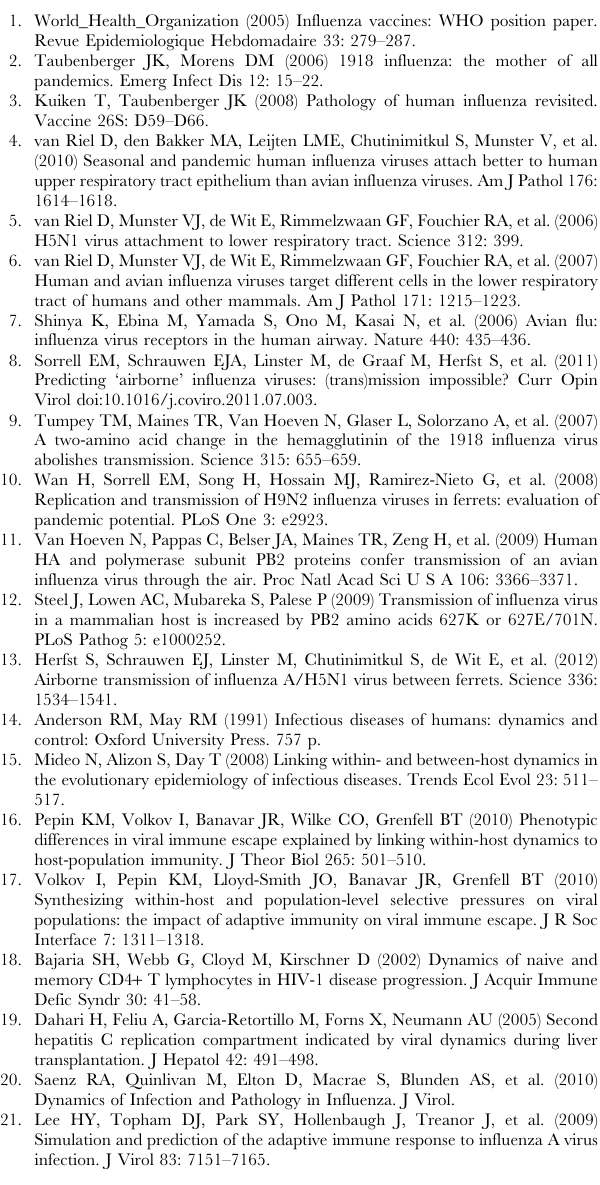
square. Infectivity rates are increasing from 1 to 5 as they differ per model. Standard errors are represented. Figure S3 Optimal patterns of tissue tropism based on more complex versions of the model. Contour plots of influenza virus reproductive number (color scales) in an immuno- logically naı¨ve population (R 0 ; left column ) and in a partially- immune population (R e ; right column ) are drawn when the infectivity rates b 2 (x axis) and b 1 (y axis) are varied. In all cases, the infectivity rate b 3 is kept constant and equals the lowest infectivity rate in the explored range (10 2 10 h 2 1 ). First row: the within-host model of infection dynamics includes birth and death processes of respiratory epithelial cells. Second row: the within- host model of infection dynamics includes additional components of the immune response, namely antigen-presenting cells, NK cells, T-helper cells, plasma-B cells and CTL. CTL production rate increases deeper down the respiratory tract. Third row: